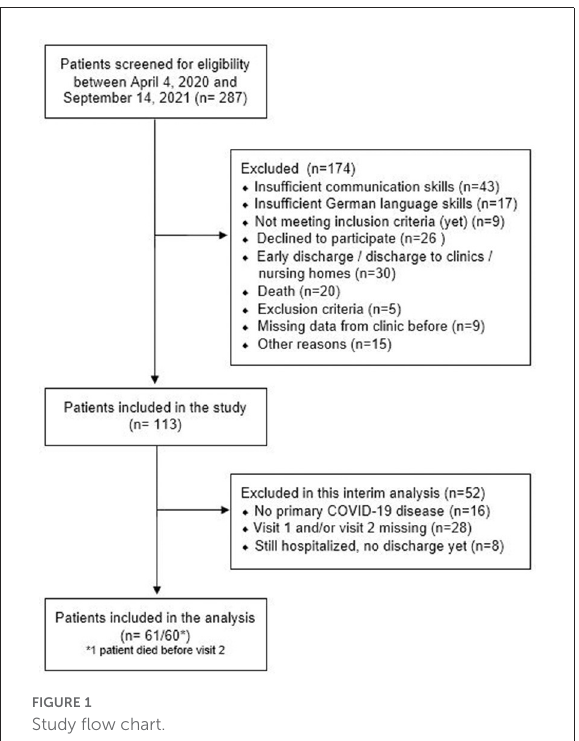
FIGURE1 Study flow